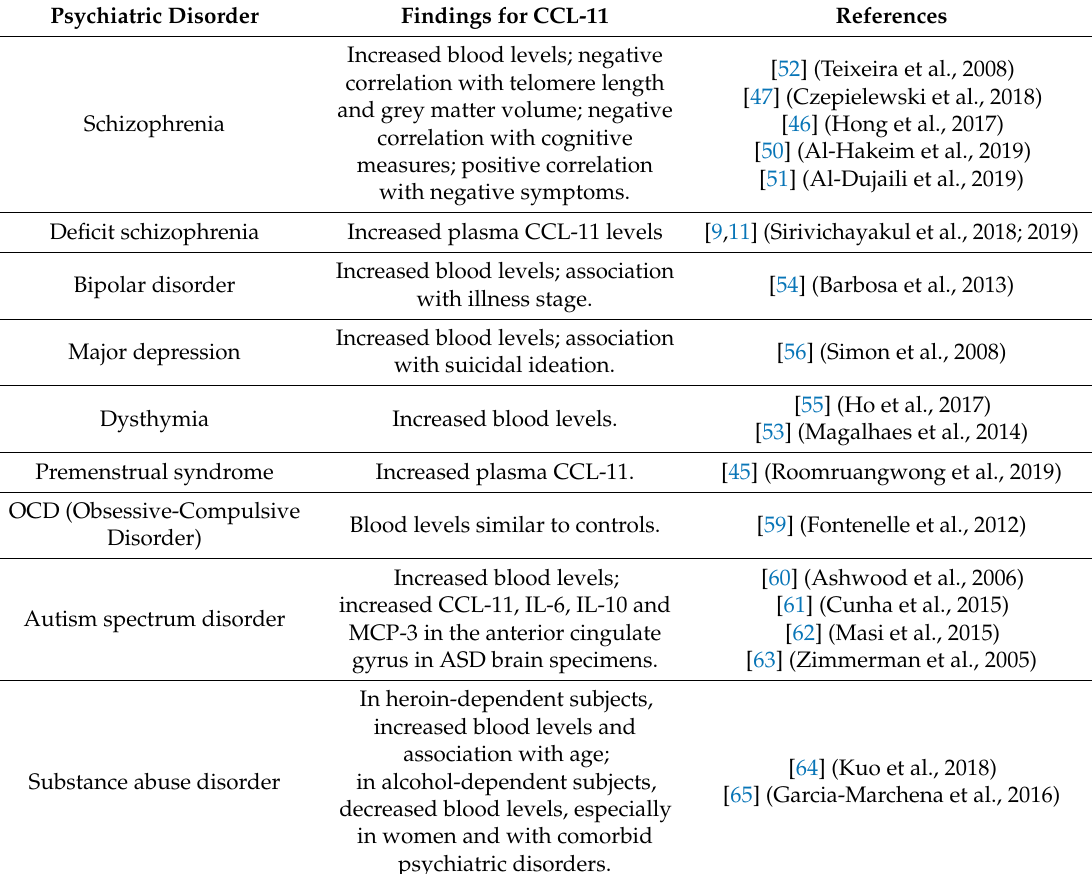
Table 3. Studies on CCL-11 regarding di ff erent psychiatric